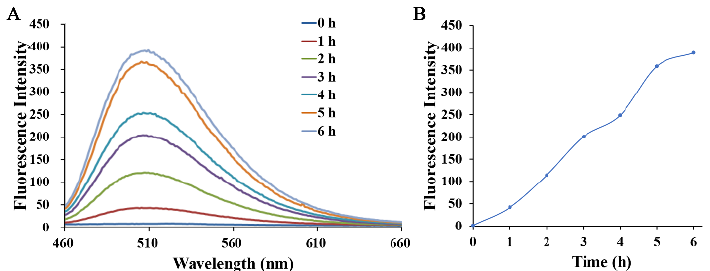
Figure 5. ( A ) Time-dependent fluorescence emission spectra of H6M (5 μ M) incubated with NTR (10 μ g/mL) and NADH (500 μ M) in 10% DMSO aqueous with an excitation wavelength at 450 nm. ( B ) Fluorescence spectroscopic changes at 500 nm were monitored at 1-h intervals (pH = 4.00).